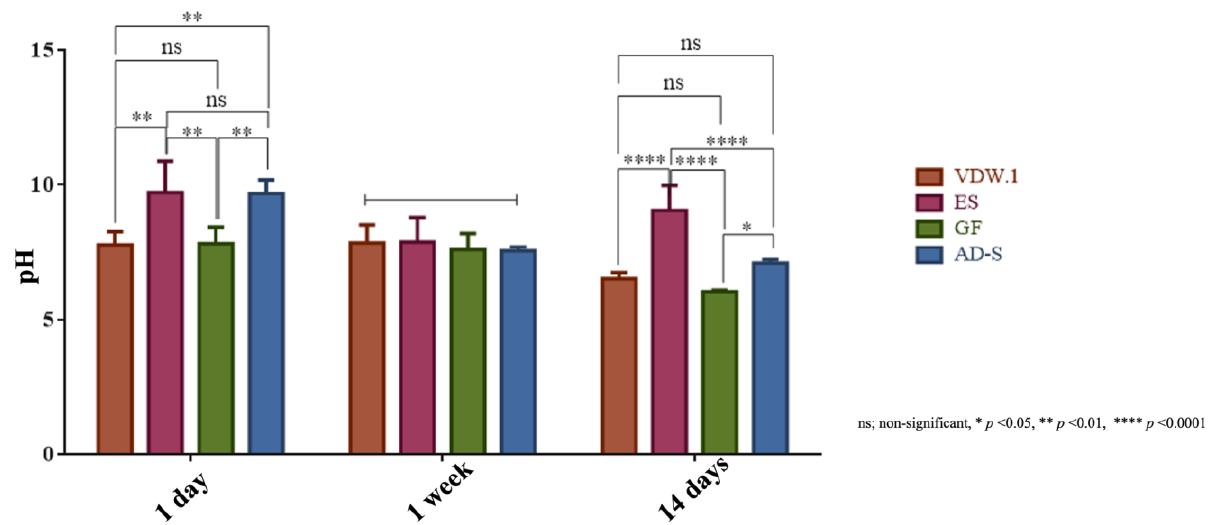
Figure 8. pH values of the different sealers, given as means and standard deviations at day 1, after 1 week, and after 14 days. VDW.1—VDW.1Seal, ES—Endosequence BC Sealer HiFlow, GF— GuttaFlow-2,